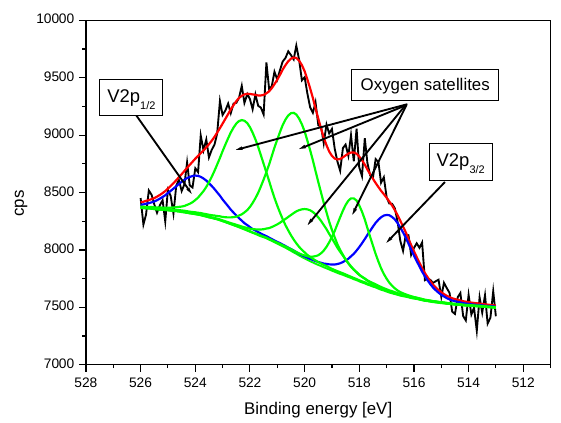
Figure 7. High resolution XPS spectra of vanadium V2p region of sample with V = 0.07 M. Fig.7. High resolution XPS spectra of vanadium V2p region of sample with V = 0.07M. lization of titanium and titanium-vanadium compounds as Fig.7. High resolution XPS spectra of vanadium V2p region of sample with V = 0.07M. sorb light in shorter range – 400–600